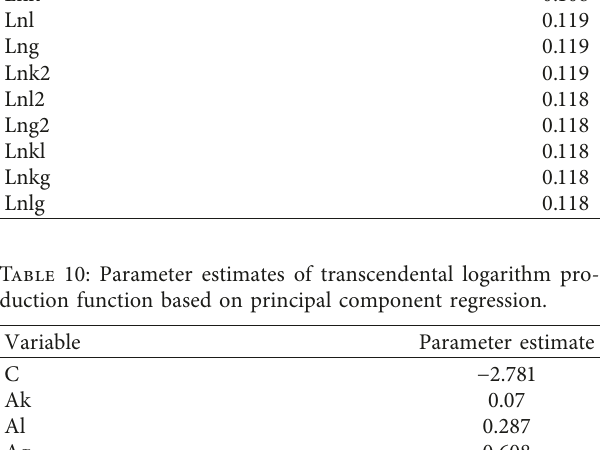
Table 9: Component score coefficient matrix. Variable